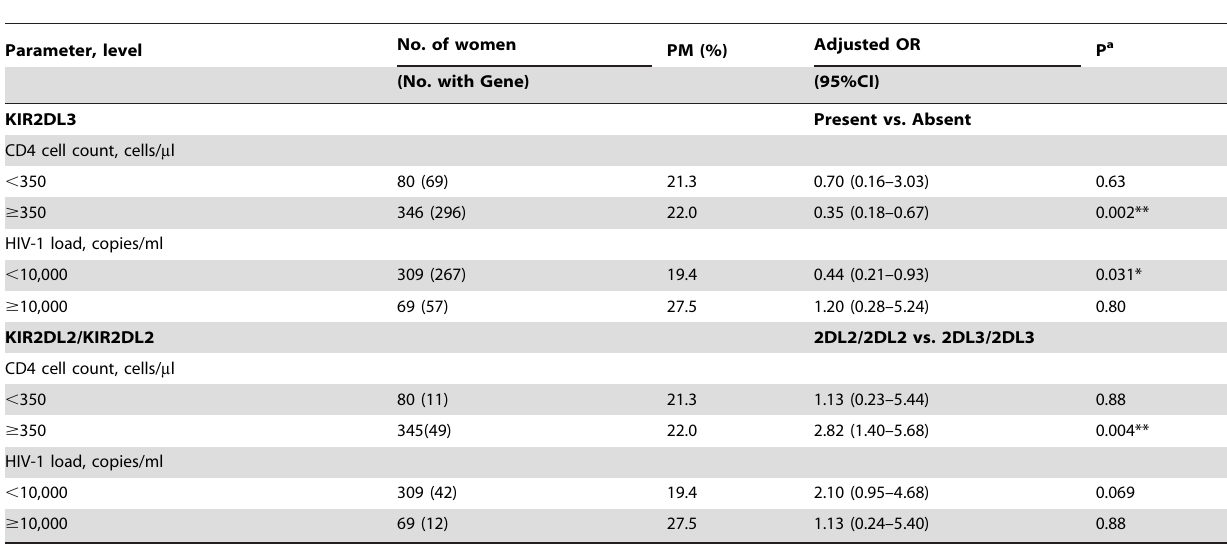
Table 4. Effect of CD4 cell count and HIV viral load on the relationship of KIR2DL3 and KIR2DL2/KIR2DL2 with PM in HIV-1 infected women, outcome placental malaria (PM)